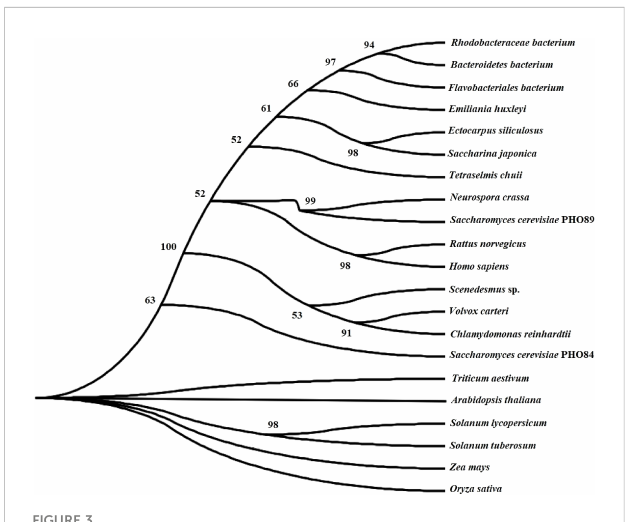
FIGURE 4 SjPT expression and growth of the blade length and width of S.japonica at different observation days. (A) SjPT expression detected with qRT-PCR. (B) SjPT expression examined by RNA-Seq. (C) The growth of the blade length and width of S.japonica .